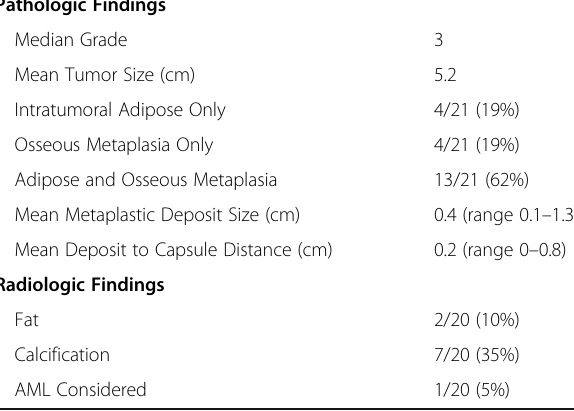
Table 2 Clinicopathologic and radiologic findings Pathologic